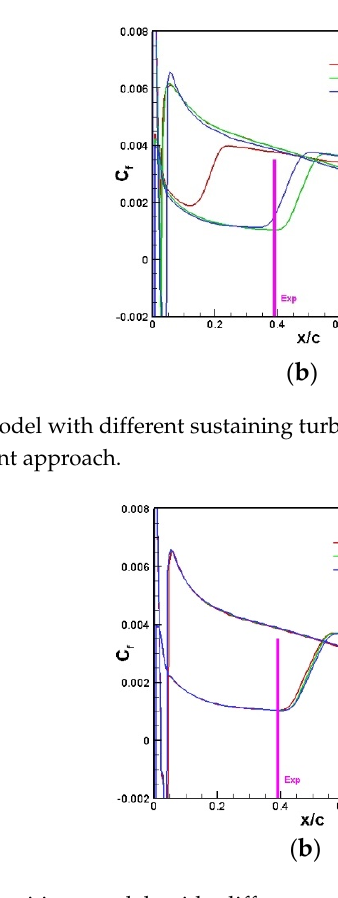
Figure 10. γ -Re θ t -CF SST2003 transition model with different sustaining turbulence terms. ( a ) Sus- taining turbulence approach in [4]. ( b ) Present approach. Table 2. Transition locations verse different values of R T,FS